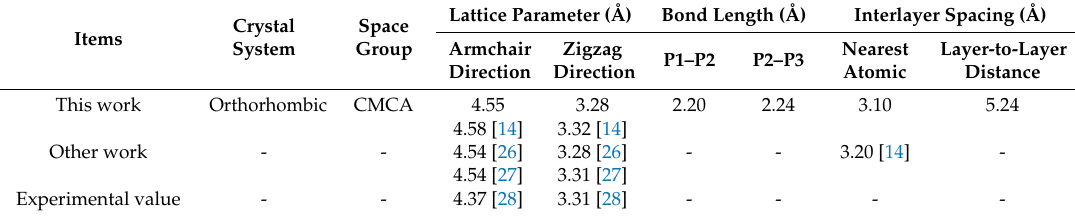
Table 1. The corresponding parameters of black phosphorus